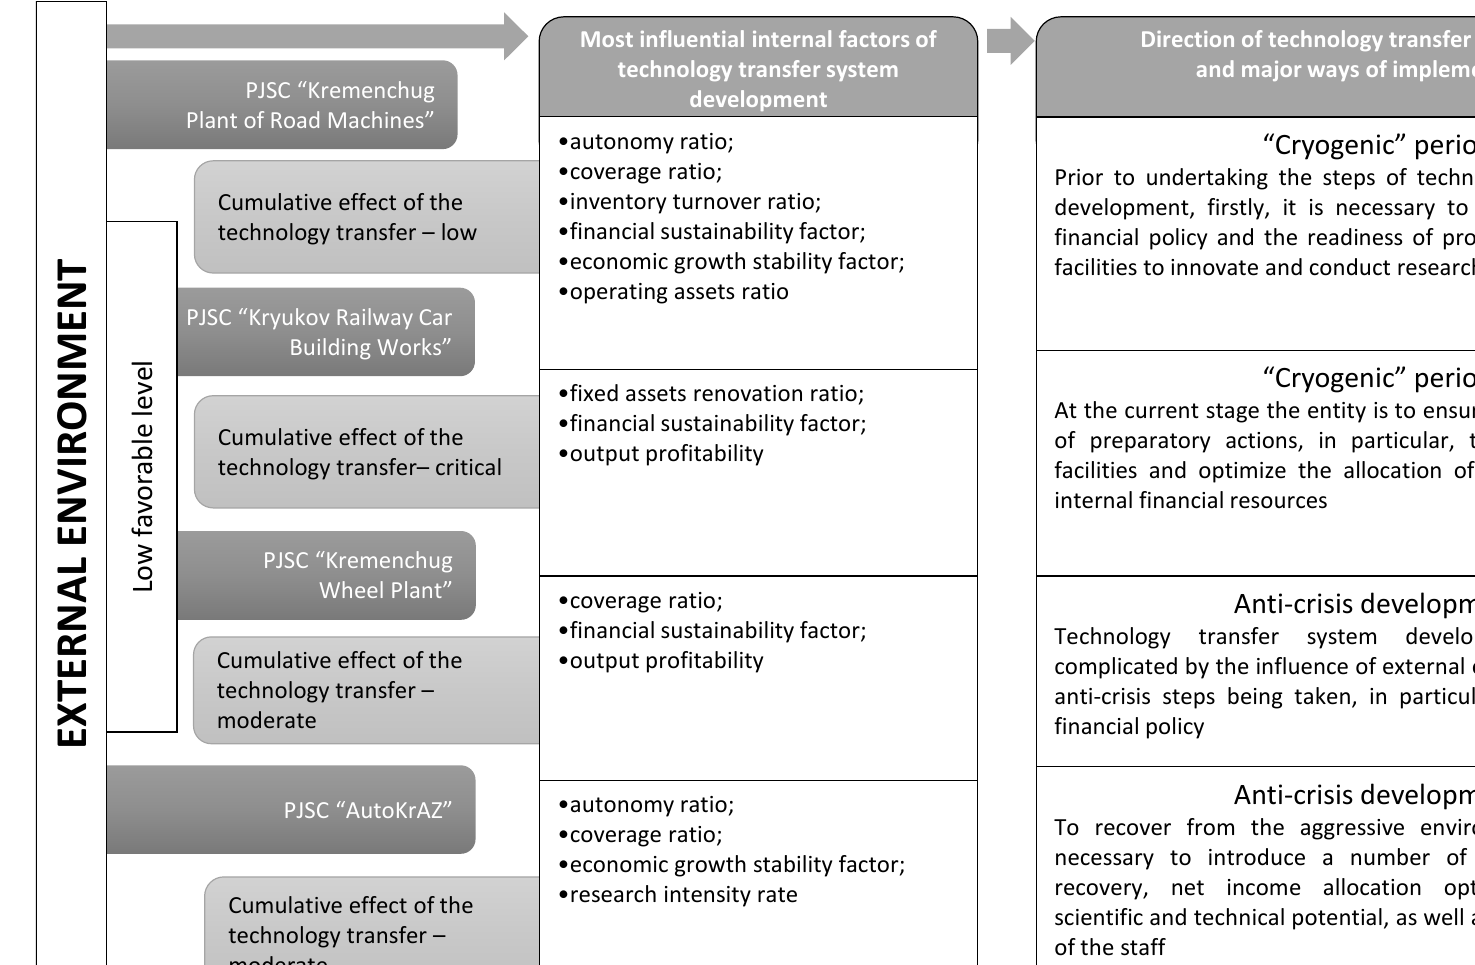
Figure 7. Defining the direction of intra-firm technology transfer system development at PJSC “Kremenchug Plant of Road Machines”, PJSC “Kryukov Railway Car Building Works”, PJSC “Kremenchug Wheel Plant”, PJSC